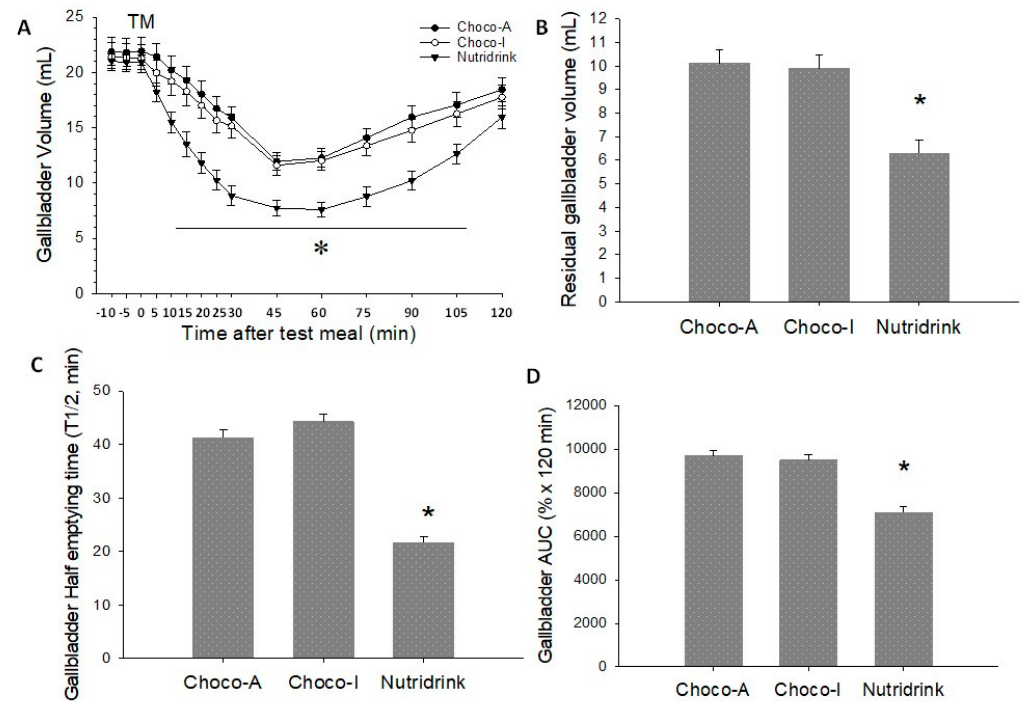
Figure 5. Gallbladder emptying parameters in response to ingestion of chocolates and test meal. ( A ) Time-dependent changes of gallbladder volume as mL; ( B ) Residual gallbladder volume as mL; ( C ) Half-emptying time as min; ( D ) Area under emptying curve (AUC). Data are expressed as means ± SEM. * p < 0.05 vs. Choco-A and Choco-I.